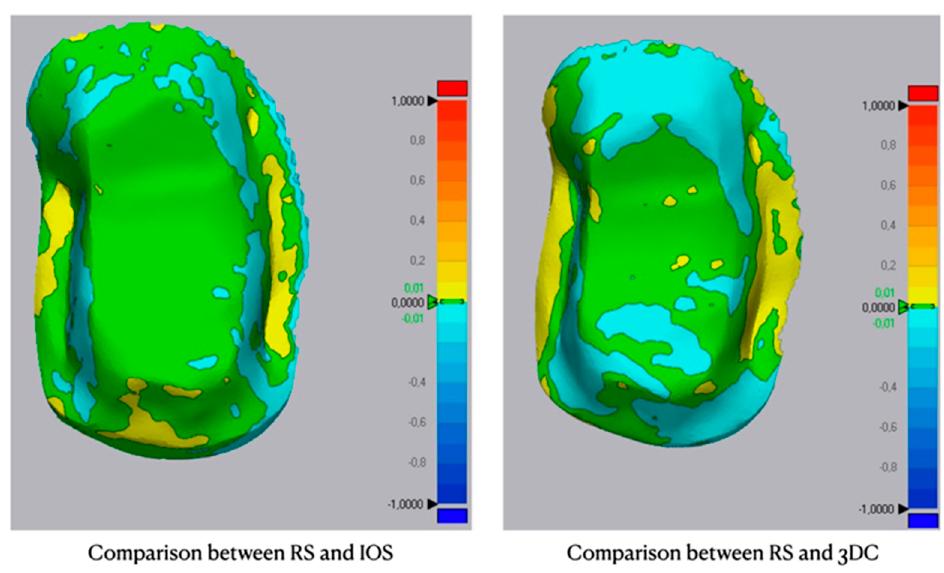
Figure 2. Random sample analysis. The image on the left represents the comparison between RS and IOS, while the image on the right between RS and 3DC. The tolerance of 10 µ m is shown in green, while other values scale from yellow to red (positive discrepancy up to 1 mm) and from cyan to blue (negative discrepancy up to − 1